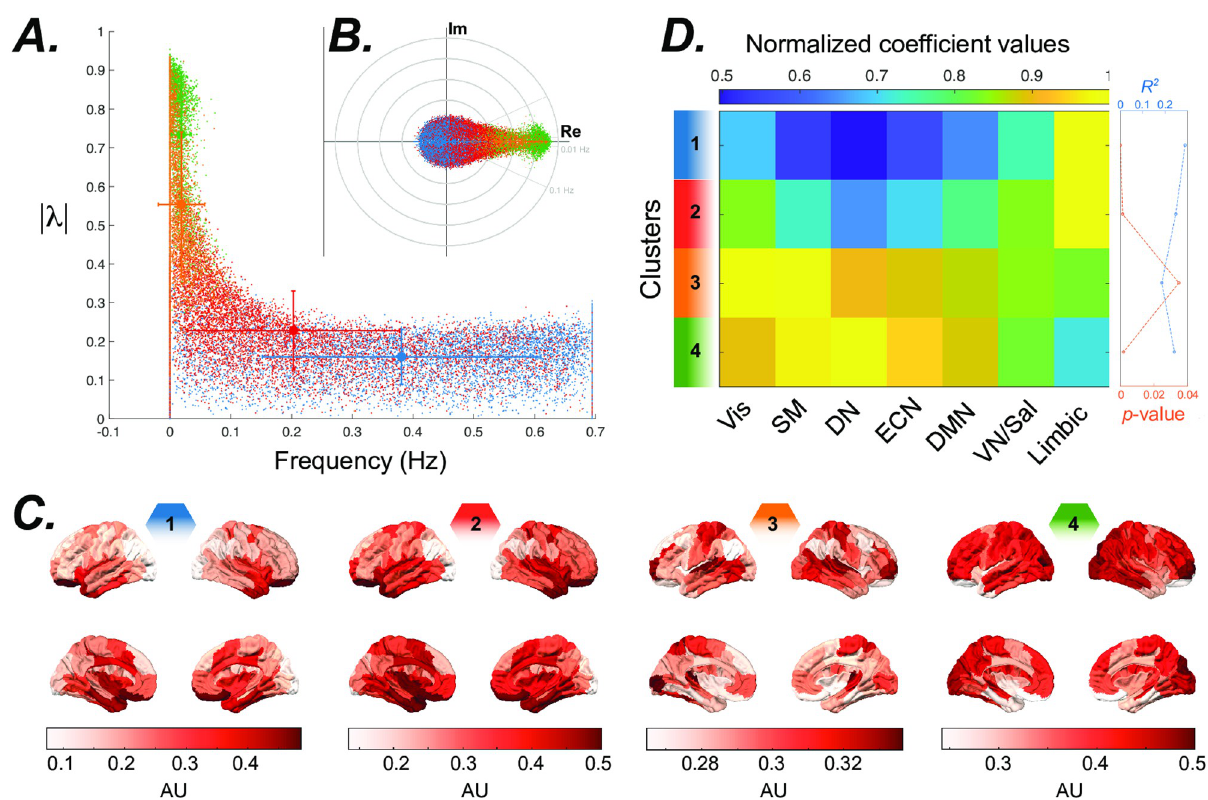
Fig 3. Eigenmodes estimated from the full (1200 TR � 14.5 min) resting-state time series. (A) Distribution of frequency versus stability of eigenvalues during resting-state. Clustering the eigenvalues based on their eigenvector’s similarity highlights the spectral profile of different systems. All eigenvectors from all subjects were normalized and grouped into 4 clusters using the k -means clustering algorithm. We color-coded the clusters identified across subjects and all resting-state sessions ( n = 4). (B) the inset plot shows the eigenvalues’ distribution. (C) The brain overlays represent the spatial distribution of the eigenvector associated with an eigenvalue (displayed with the same color code) that is at the centroid of each cluster. (D) The similarity between eigenvector clusters’ centroids and the resting-state networks. We performed spatial multiple linear regression analyses using all resting-state networks identified by [50], namely the visual (Vis), sensory/motor (SM), dorsal attention (DN), ventral attention/salience (VN/Sal), limbic, executive control (ECN), and default mode network (DMN) as the explanatory variables, to show which resting-state networks overlap with the eigenvector clusters’ centroids shown in the panel. The color-coded matrix shows the estimated normalized (divided by maximum value at each row) coefficients of the regression, calculated separately for every eigenvectors’ cluster’s centroid. The plot on the right shows the p -value and R 2 calculated for each cluster